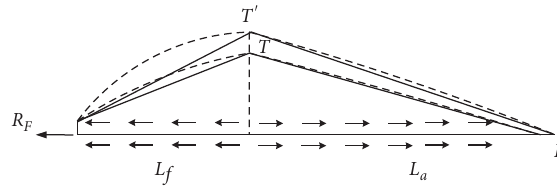
Figure 17: Force acting on the soil